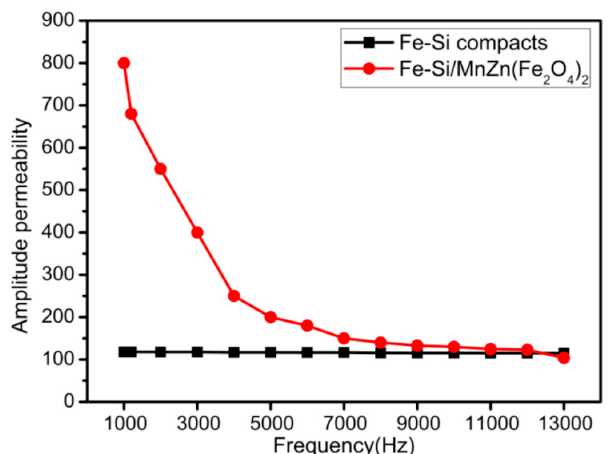
Figure 14. Dependence of amplitude permeability for the Fe-Si composite compacts and Fe-Si/MnZn(Fe 2 O 4 ) 2 composite compacts sintered at 900 °C measured at frequency range 1 kHZ to 13 kHZ, B m = 0.1 T.